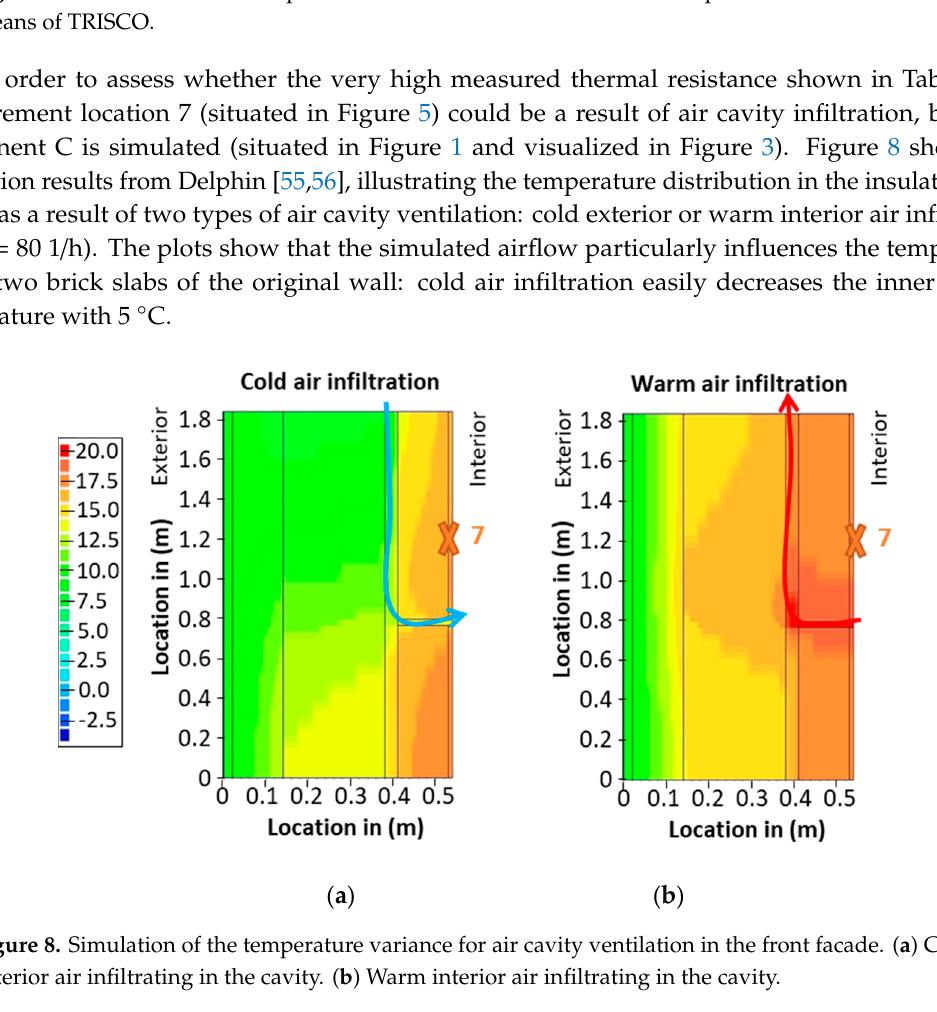
Figure 8. Simulation of the temperature variance for air cavity ventilation in the front facade. ( a ) Cold exterior air infiltrating in the cavity. ( b ) Warm interior air infiltrating in the cavity.